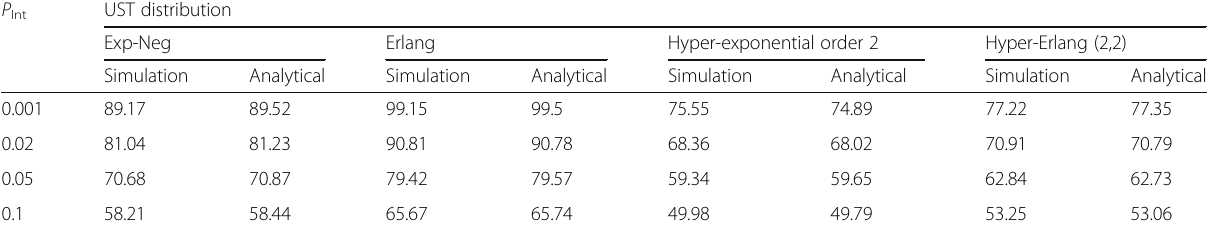
Table 3 Mean of the CHTn for different distributions of the UST when CDT is exponentially distributed P Int